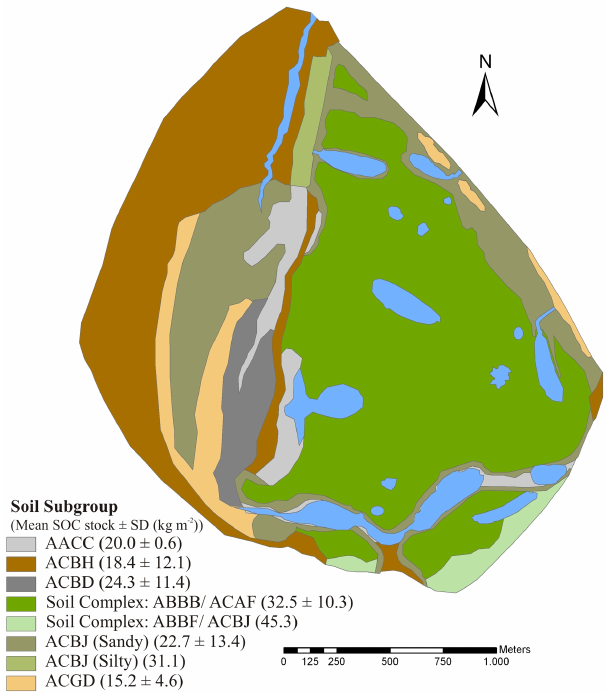
Fig. 7. A soil map of Samoylov Island as a result of long-term soil research within this area. Generated from data by Pfeiffer et al. (2000) and Pfeiffer et al. (2002) (compare Sanders et al., 2010). Soil classification according to the US Soil Taxonomy (Soil Survey Staff, 2010). Mean soil organic carbon stocks with their standard deviations for the soil units down to 100cm depth are provided in parentheses after each soil subgroup. (ACRONYM – soil subgroup (number of soil cores)): AACC – Fluvaquentic Fibristel (2), ACBH – Psammentic Aquorthel (5), ACBD – Ruptic-Histic Aquorthel (3), Soil Complex: ABBB/ ACAF – Glacic Aquiturbel / Typic His-